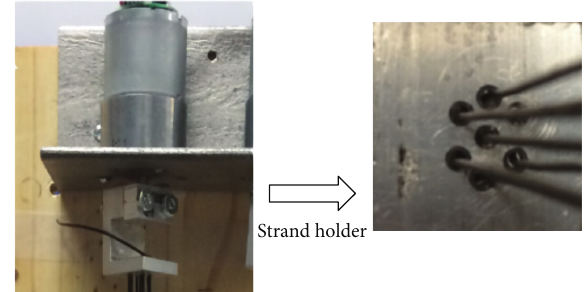
Figure 5: Alignment of an untwisted 7-strand